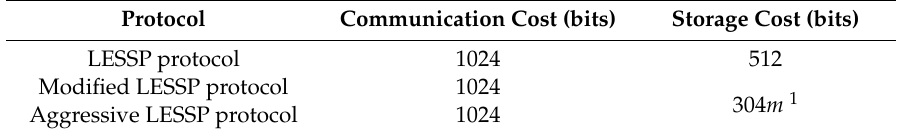
Table 4. Communication and storage costs in one run of each protocol.